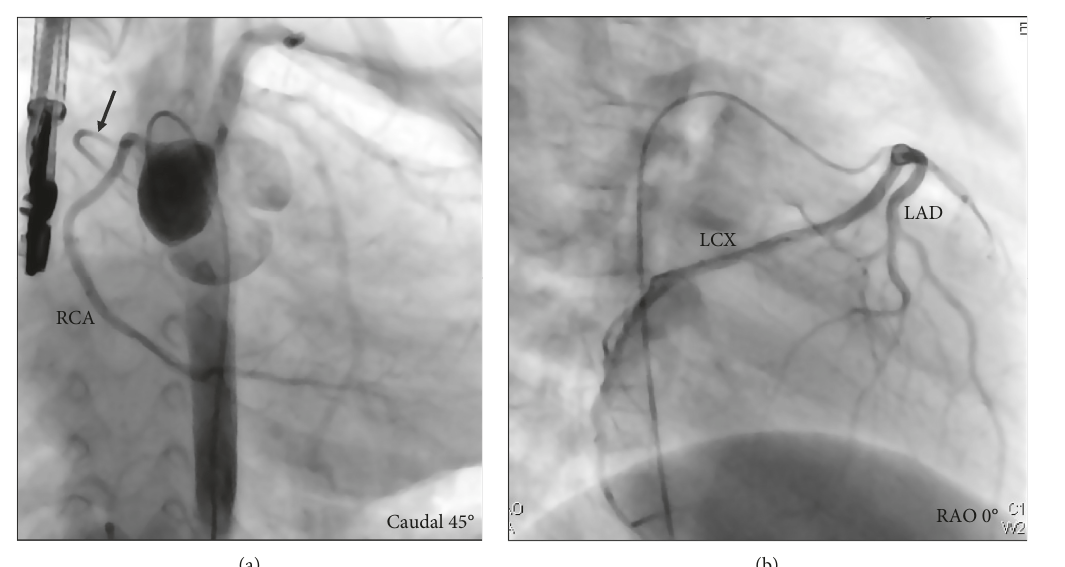
Figure 3: Coronary angiography (on day 25 of the illness). The arrow indicates sinus node branch from the right coronary artery. There was no dilatation or stenosis of the coronary arteries.